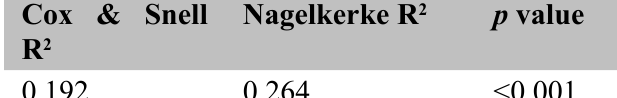
Table 5: Model summary Cox & Snell R 2